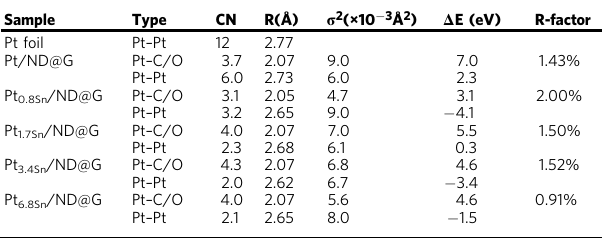
Table 1 Pt L 3 -edge EXAFS fi tting results for as-prepared